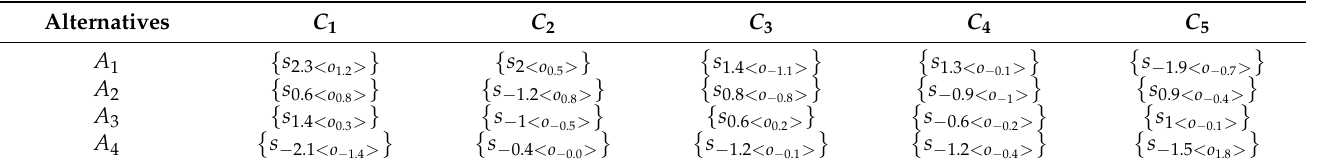
Table 3. The group DHHL decision matrix H .